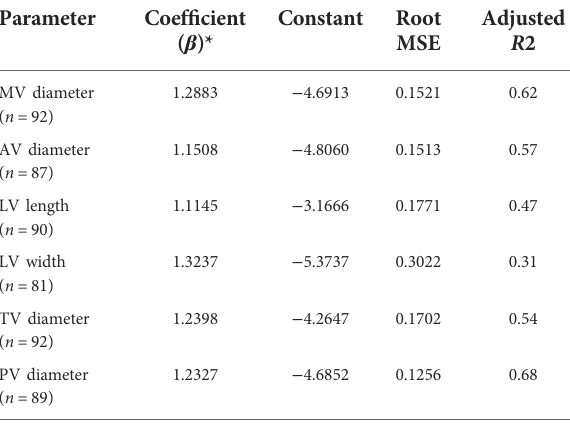
TABLE 2 Equations for prediction of echocardiographic parameters in fetuses with left CDH that survived after birth.